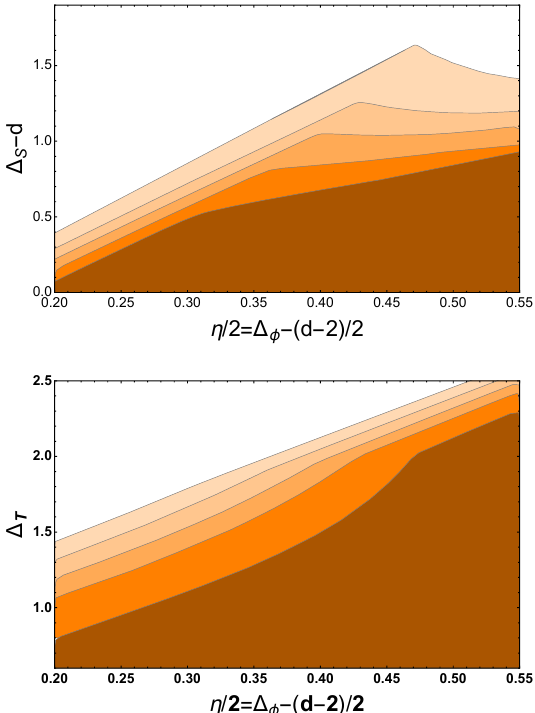
Figure 4: The numerical bounds for ∆ operator in the rank-2 symmetric traceless tensor representation) and ∆ dimension of the leading scalar operator in singlet representation) for CFTs with O ( 4 + ε ) symmetry in d = ( 2 + ε ) dimensions. Shaded regions are consistent with bootstrap constraints, therefore allow unitary CFTs to exist. The plots correspond to ε = 0.2,0.4,0.5,0.6,0.7 from top (below) to below (top) for ∆